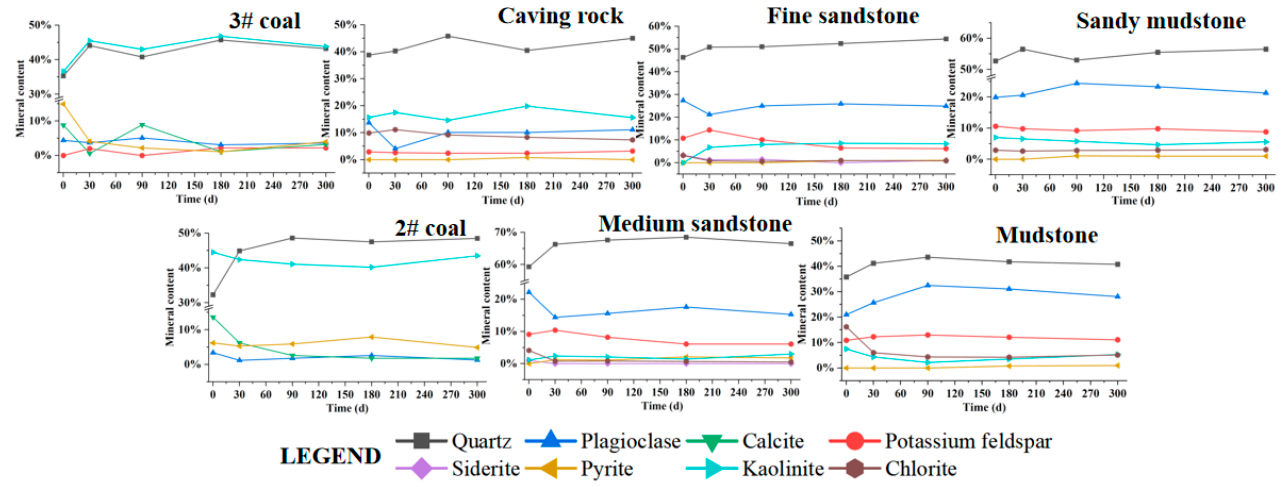
Figure 3. Mineral content changes in rock layers.